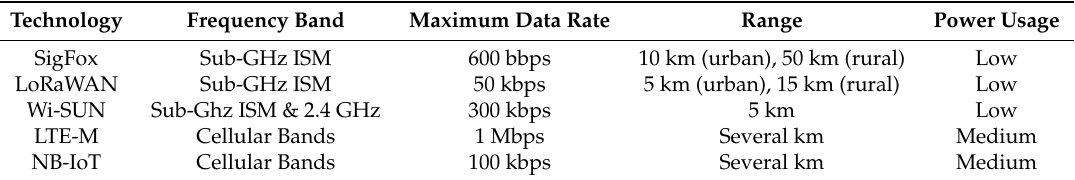
Table 2. Comparison of some Low-Power Wide-Area Network (LPWAN) technologies [58–63].